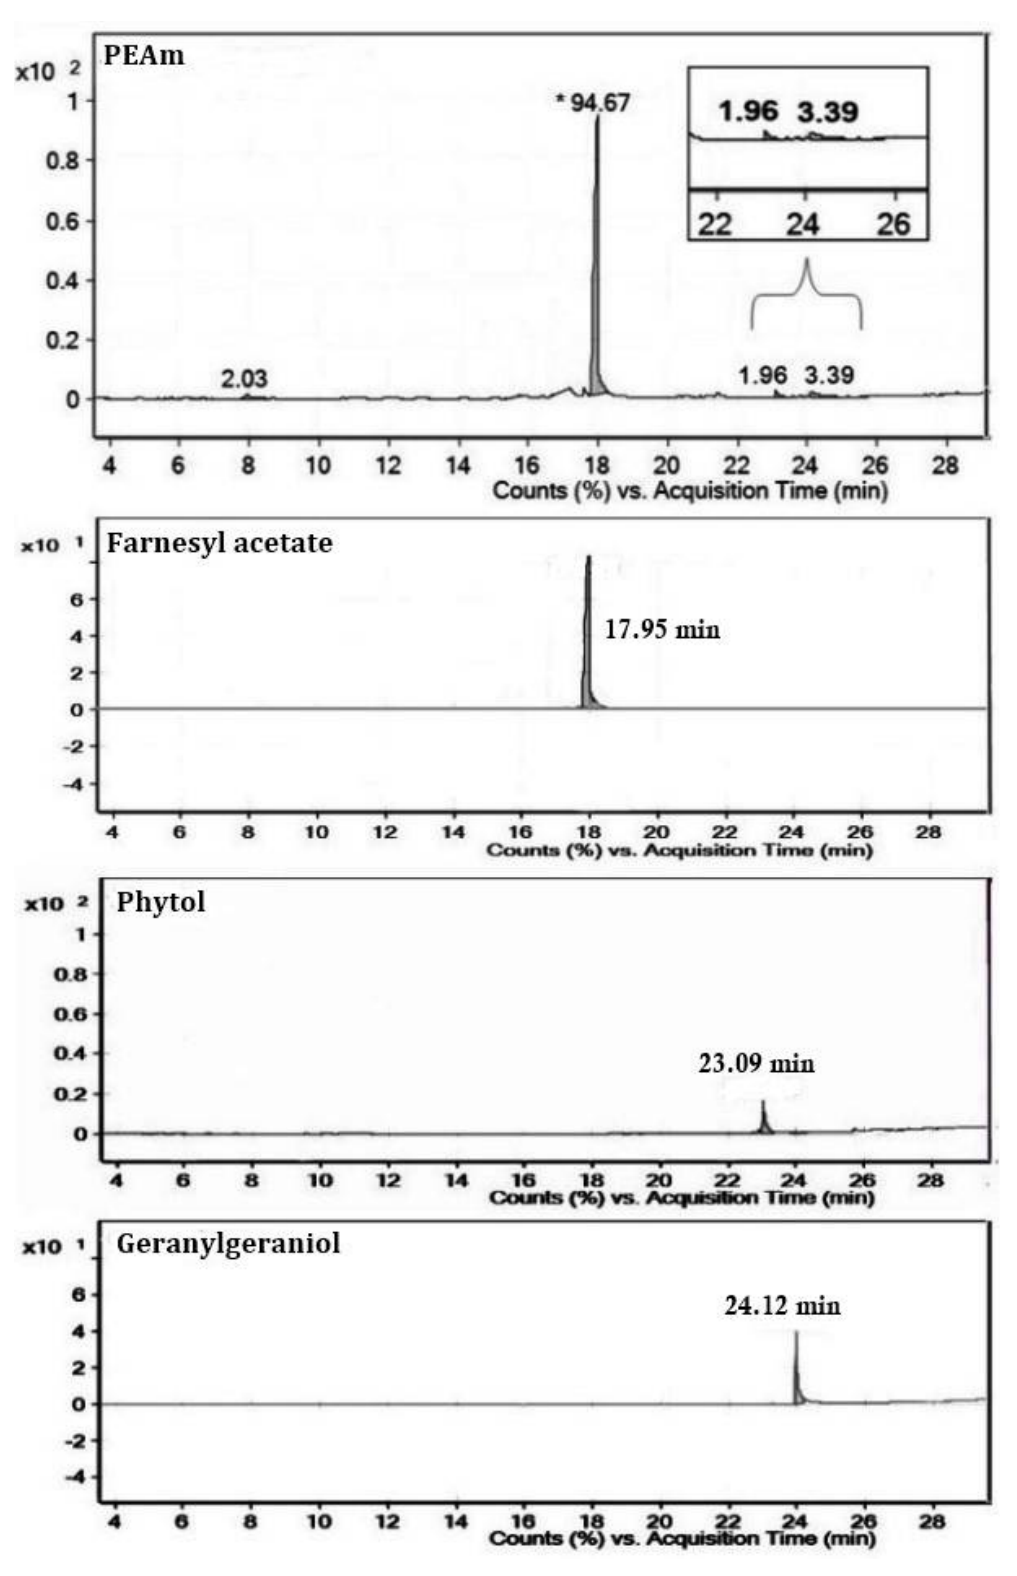
Figure 2. Gas chromatography-mass spectrometry analysis of petroleum ether extract from A. macroprophyllata leaves (PEAm) and farnesyl acetate, phytol and geranylgeraniol standards. The x -axis indicates the retention time in minutes, while the y -axis indicates the peak % signal intensity. * p < 0.05.